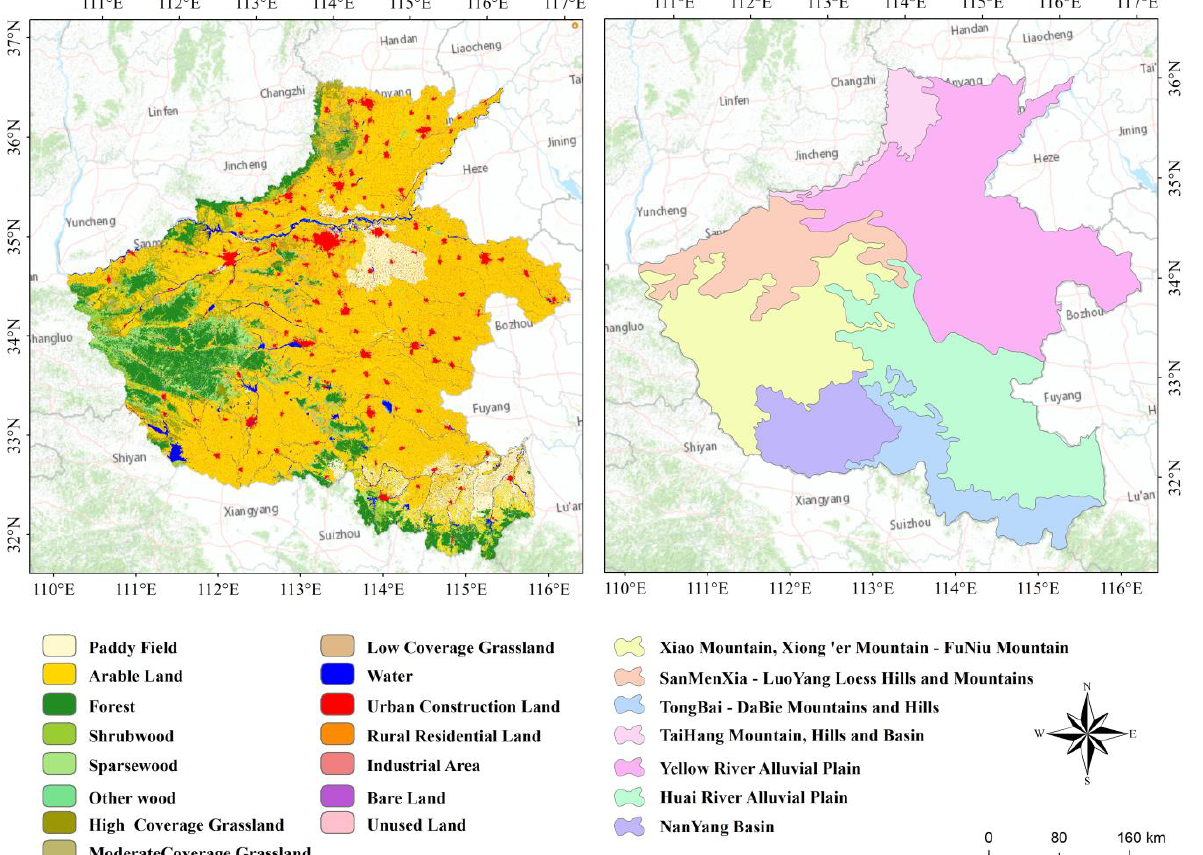
Figure 1. LUCC and geomorphological map of Henan Province .